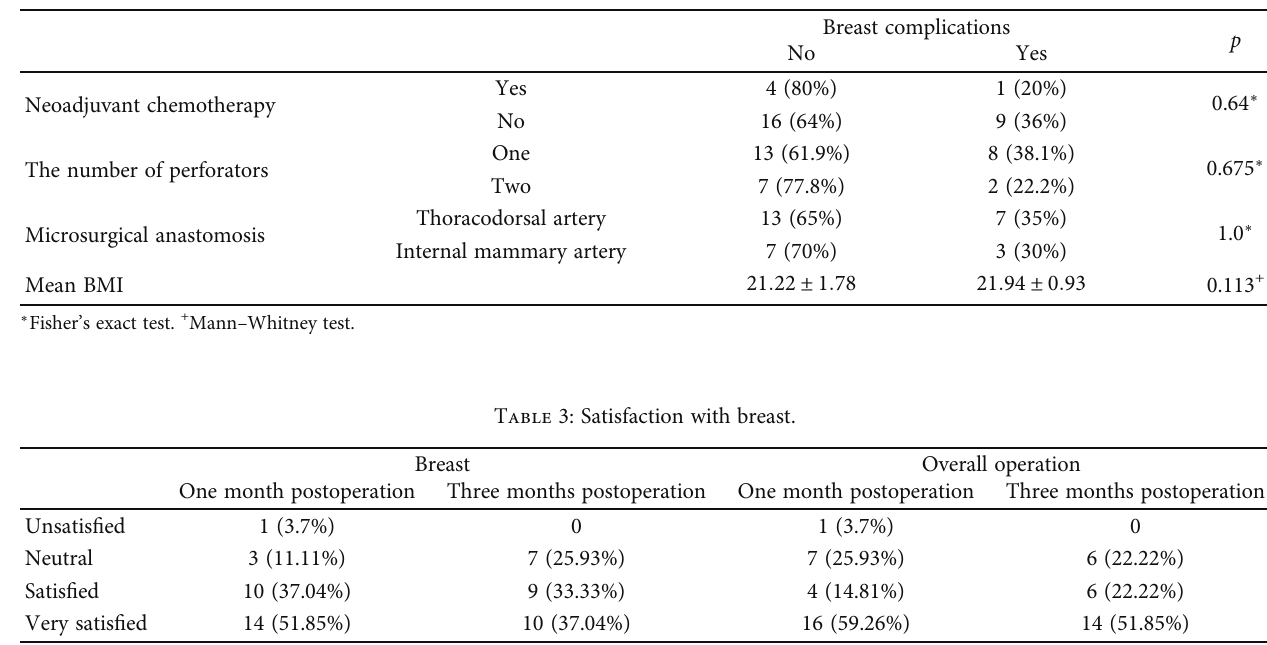
Table 2: Variables associated with breast complications.